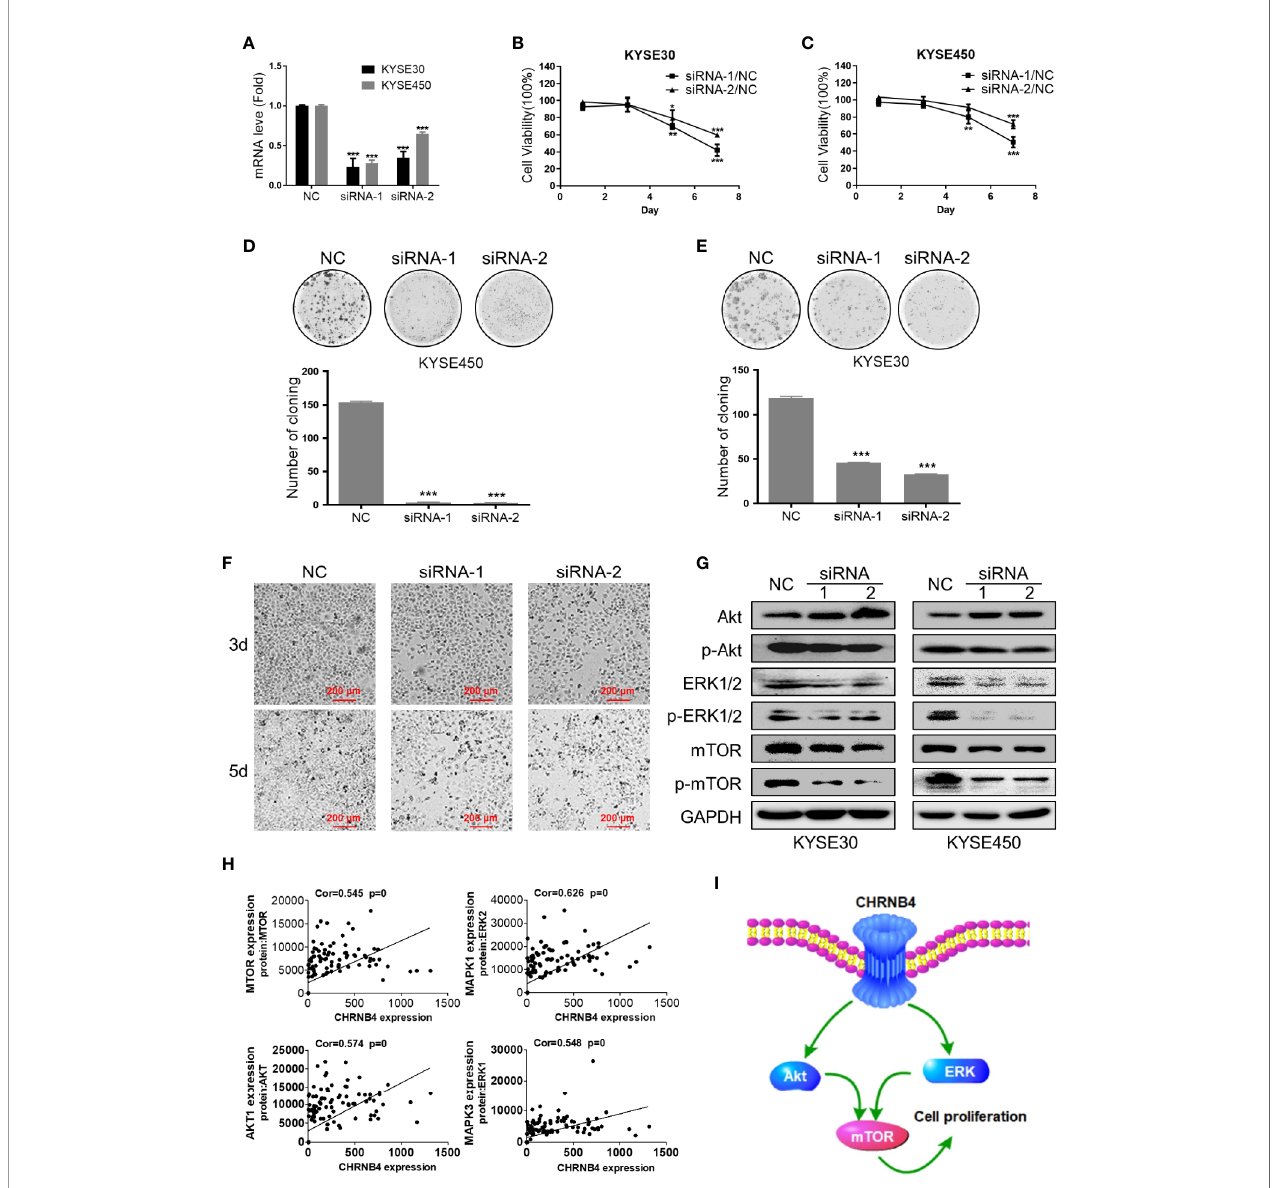
FIGURE 5 | ESCC cell growth after CHRNB4 knockdown by siRNA. (A) The interference ef fi ciency of KYSE30 and KYSE450 treated with siRNA . (B, C) The cell viability of KYSE30 and KYSE450 treated with siRNA was detected at 1, 3, 5, and 7 d at an optical density of 450 nm. (D, E) Pictures of colony formation assay of the 3 groups in KYSE450 and KYSE30 cells, respectively. Histograms of colony numbers of each group in KYSE450 and KYSE30 cells, respectively. (F) The cell morphology under the treatment with siRNA at 3 d, 5 d of KYSE30. (G) Protein levels of Akt, P-Akt, mTOR, P-mTOR, ERK 1/2, and P- ERK 1/2 were detected by western blot. (H) The pictures displayed the correction between CHRNB4 and genes associated with protein regulated mTOR. (I). CHRNB4 potential regulation mechanism speculates in the tumorigenesis progression of ESCC. Data are the means ± SD of three replicates. *** P < 0.001; ** P < 0.01; * P <